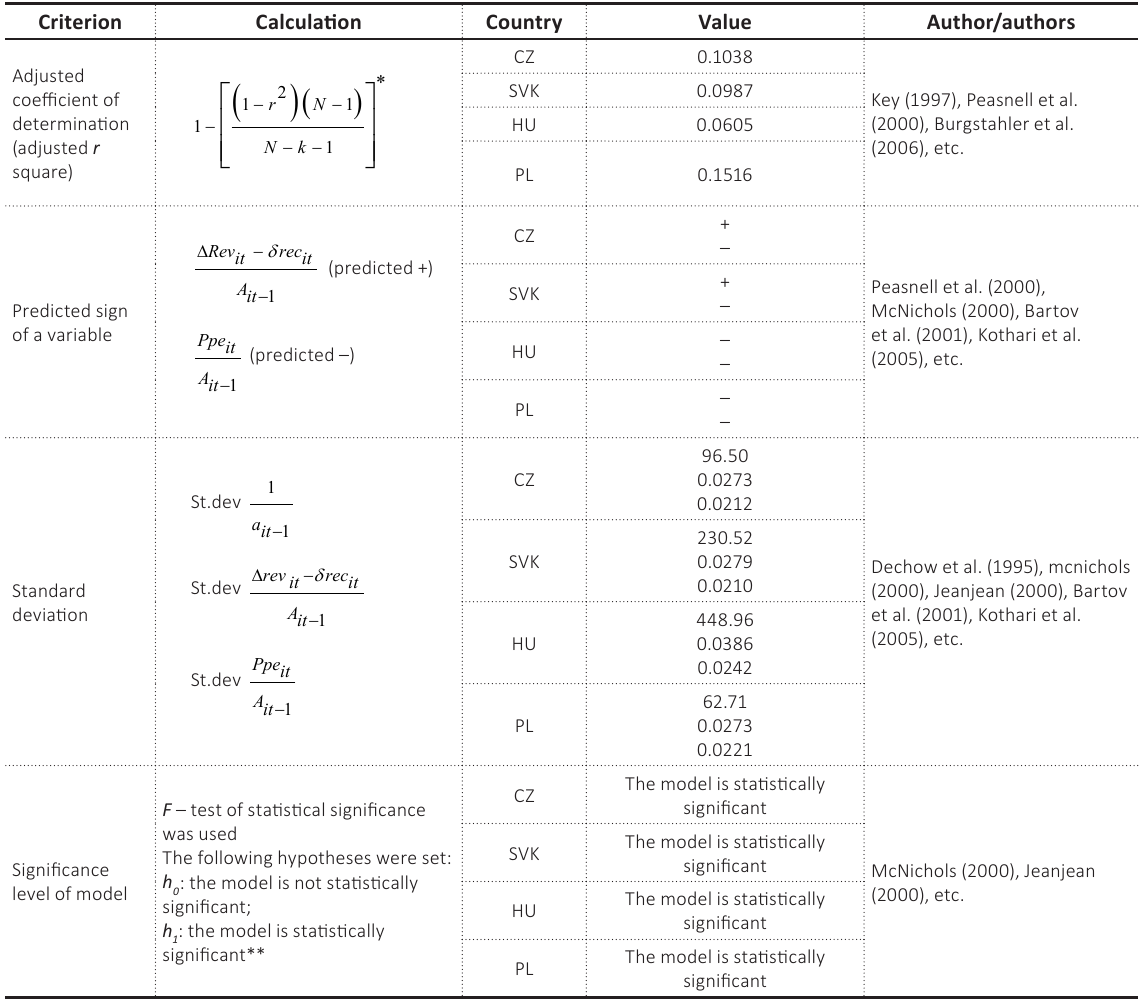
Table 4. Criteria for an explanatory power measurement of the model in calculating EM initiatives